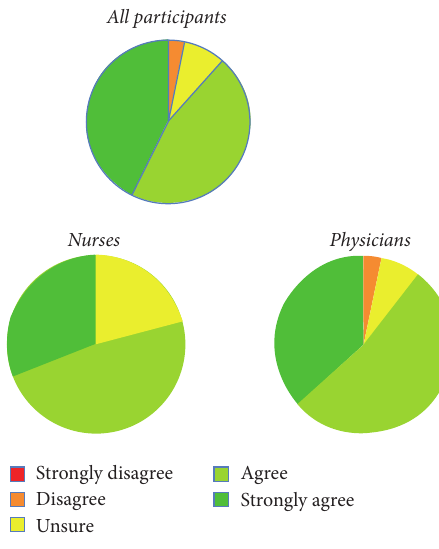
Figure 4: Agreement of the participants on curability of hepatitis C within the next five